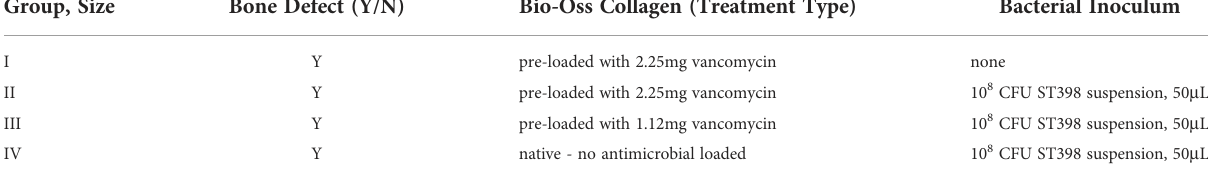
TABLE 2 Experimental